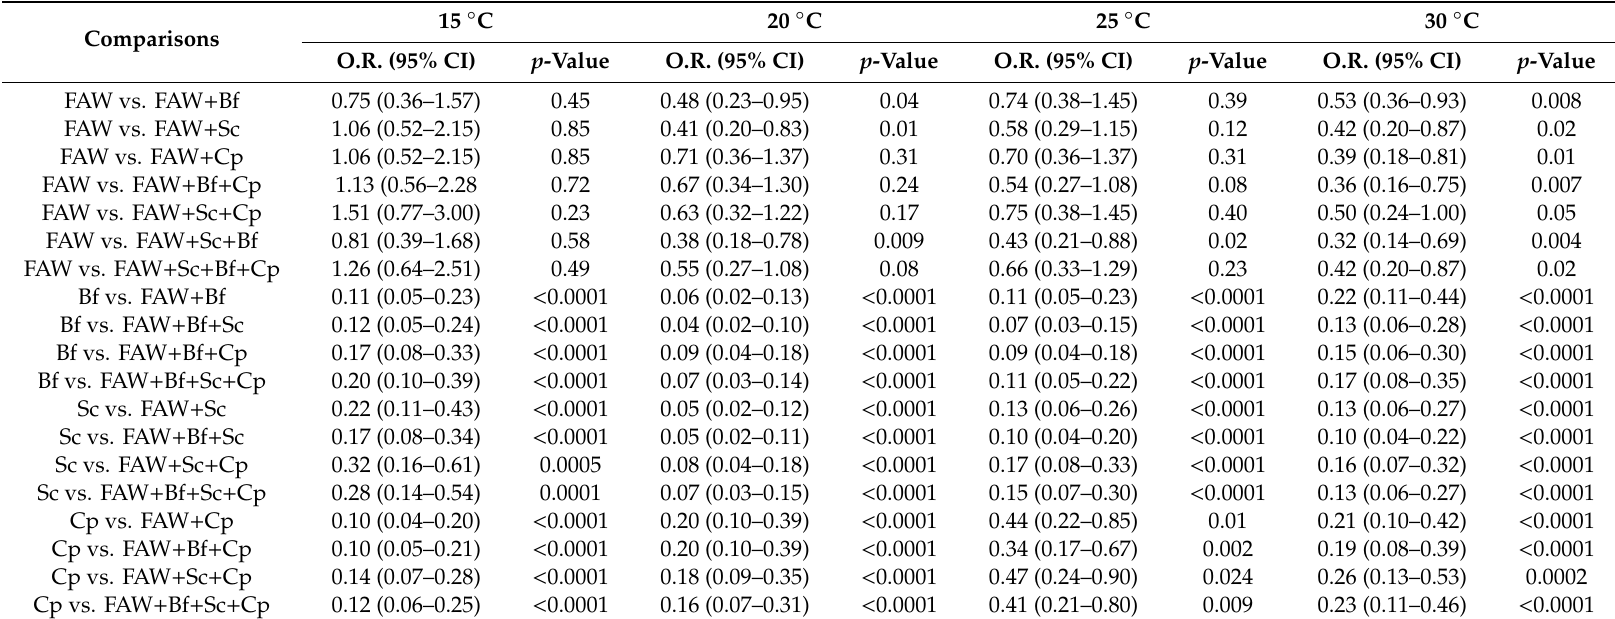
Table 5. Results of GLM analysis comparing survival between single-species and multi-species combinations under di ff erent constant temperatures.